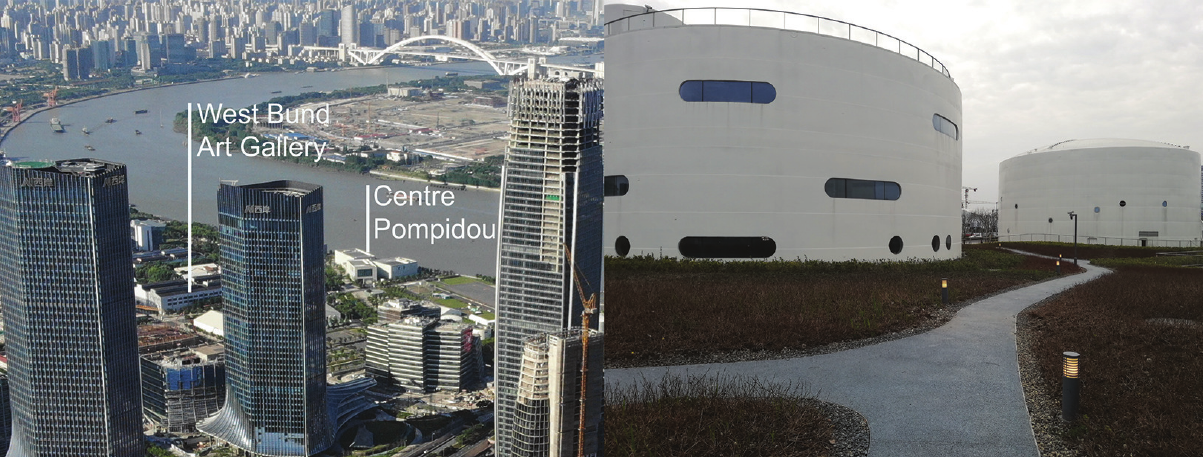
Figure 3. On the left, the AI Town under construction. Between the towers, several art institutes are still visible. On the right, the TANK Shanghai, a pioneering and multifunctional art centre in former oil storage. Source: Author (September